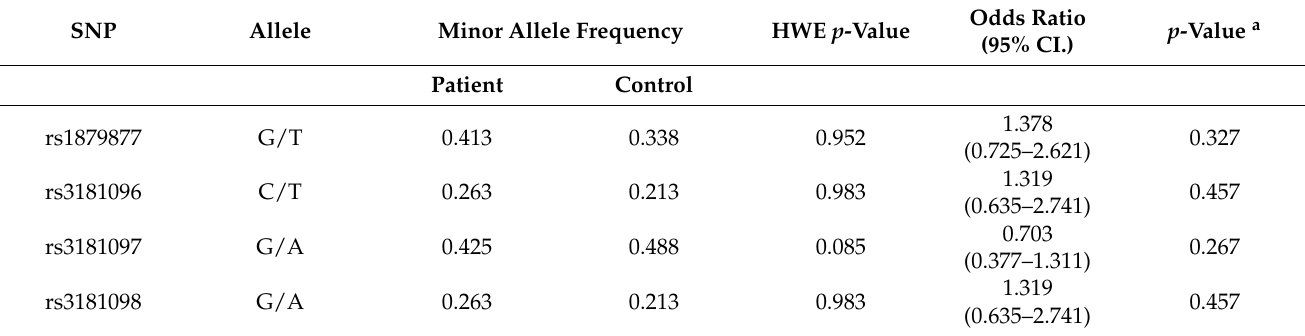
Table 3. Allele frequencies in patients and controls and odds ratio for transfusion reaction.